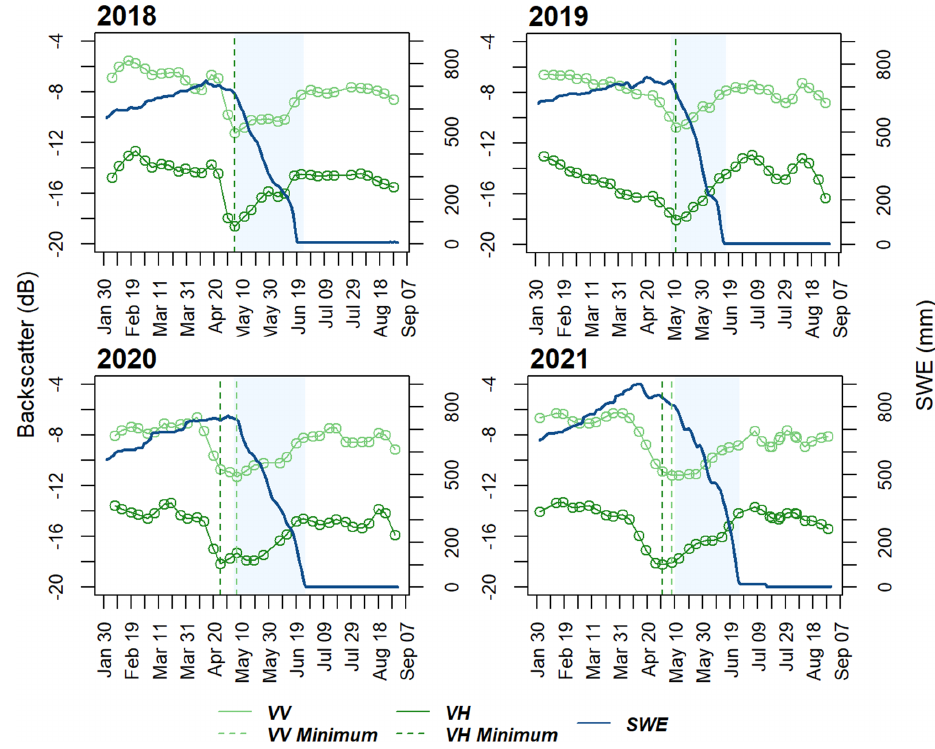
Figure 3. Comparisons of SAR time series and continuous snow water equivalence records (SWE) at Downton Lake Upper. SWE records are displayed in dark blue, with melt periods shaded in light blue. SAR time series for VV and VH polarized images are depicted in green, with time series minima denoted by dashed